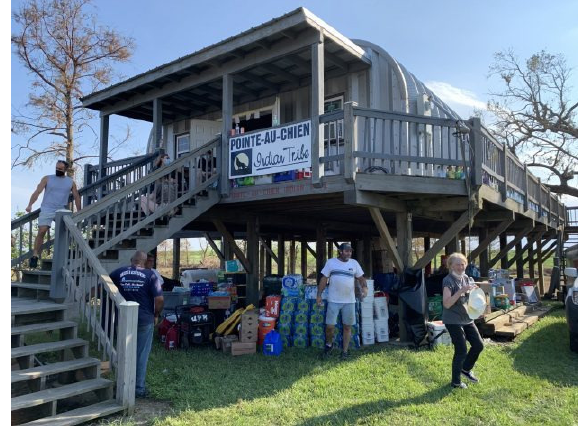
Fig. 6 Pointe-Au-Chien community distribution site that retained power supply during Hurricane Laura (Source: Courtesy of Footprint Project) [34] .